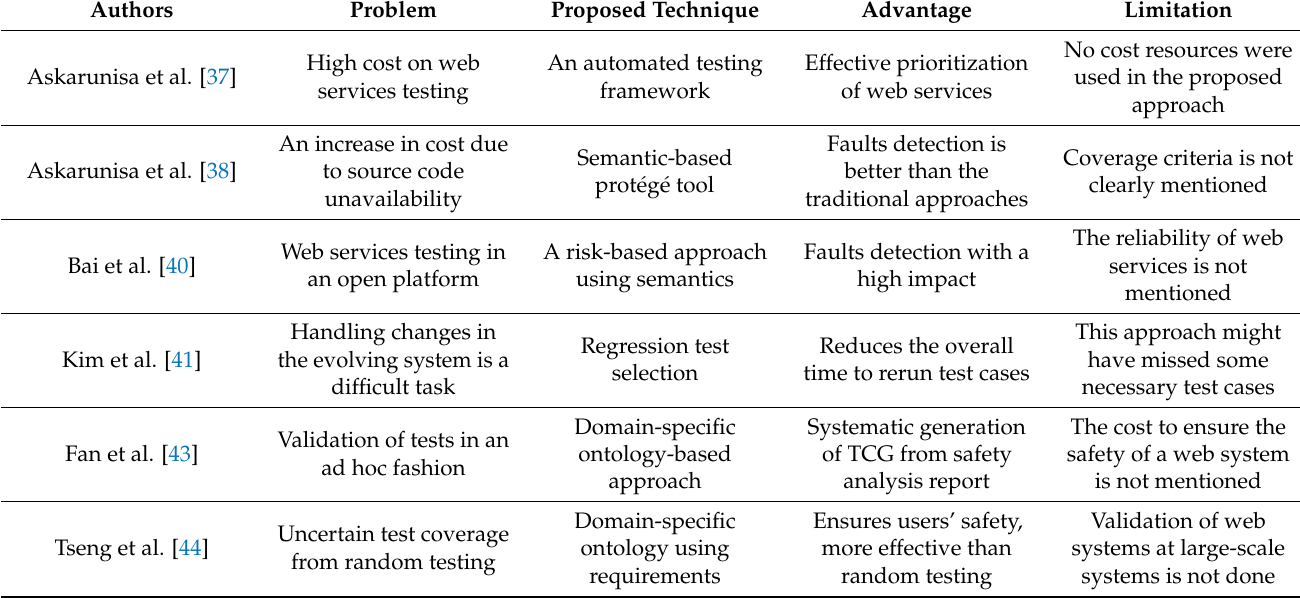
Table 5. Summary of ontology-based